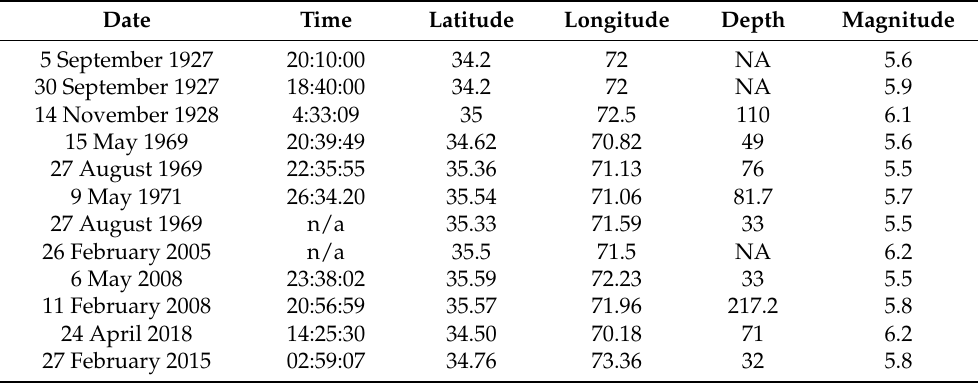
Table A2. Major instrumented earthquakes from the composite earthquake catalog used for this study (Mw ≥